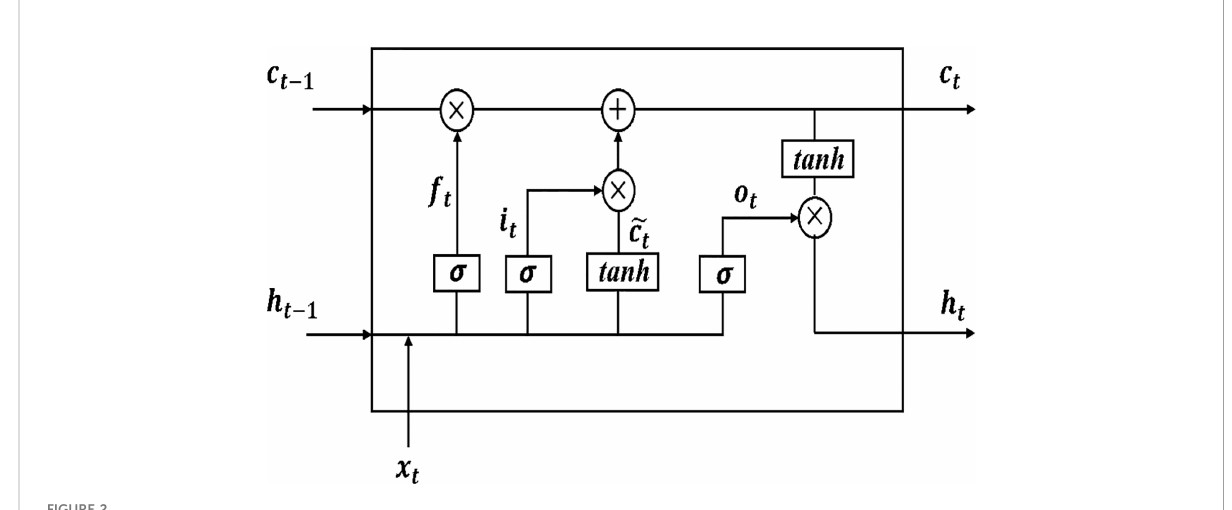
FIGURE 2 Internal structure of LSTM hidden